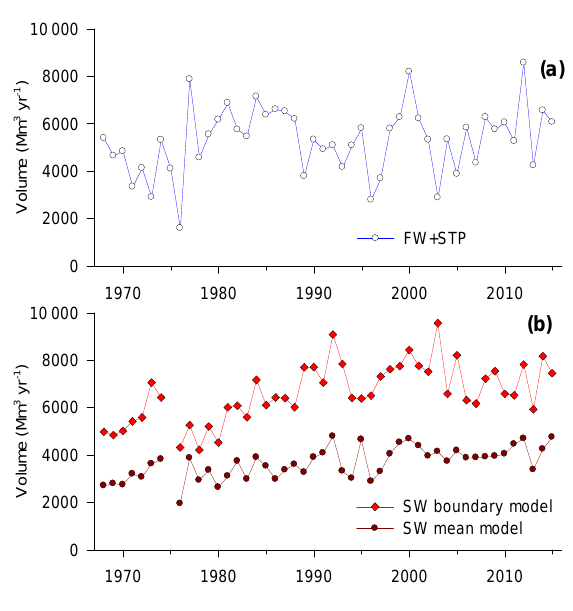
Figure 4. (a) Annual mean freshwater input (including STPs) and (b) modelled inflow from the middle archipelago (Baltic Sea) to the inner archipelago calculated with boundary and mean models (see methods). Lake Mälaren contributes 93.6 ± 2.1% (mean and SD for all years) and STPs 3.6 ± 1.2% of the total freshwater